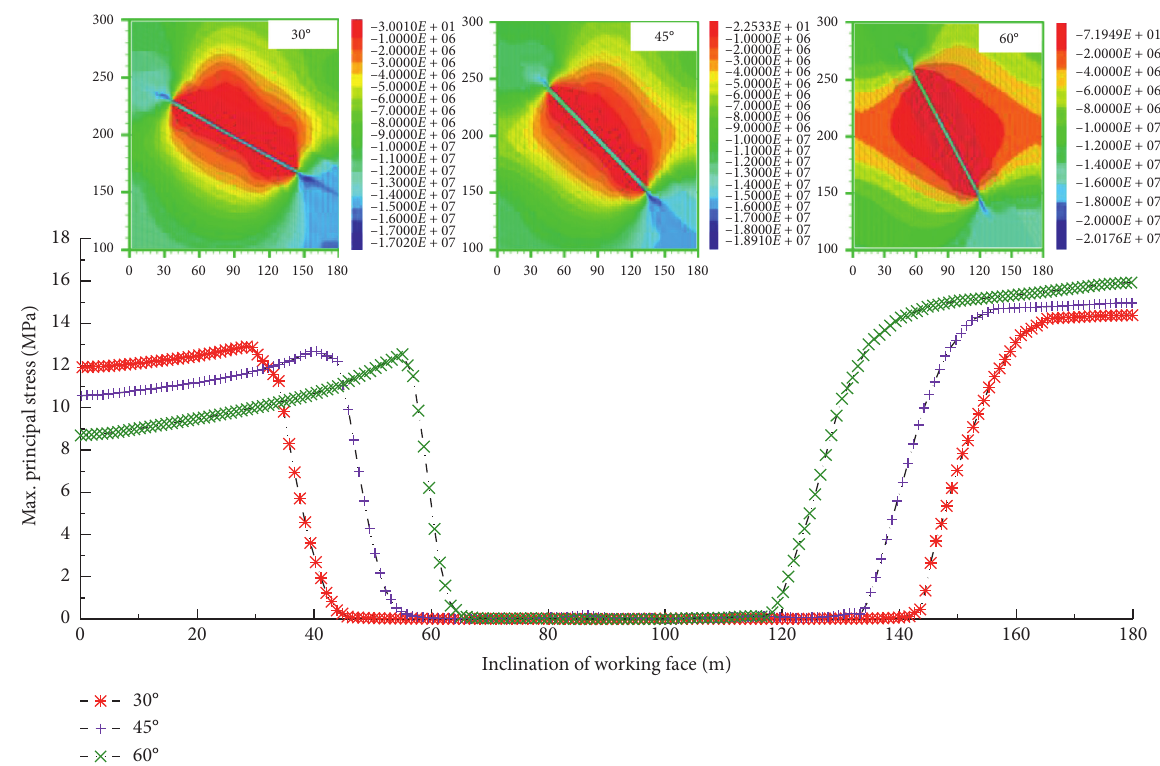
Figure 8: Distribution characteristics of maximum principal stress in different coal seam dip